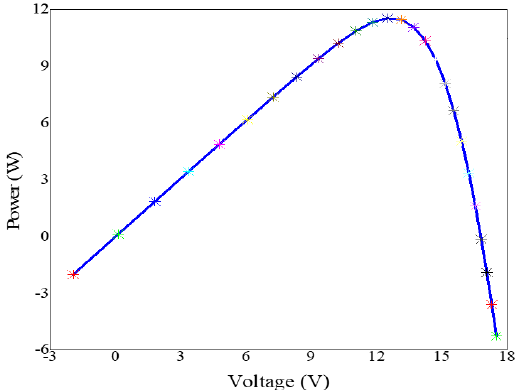
Figure 12. P–V curve obtained from the calculated current for the single-diode module.